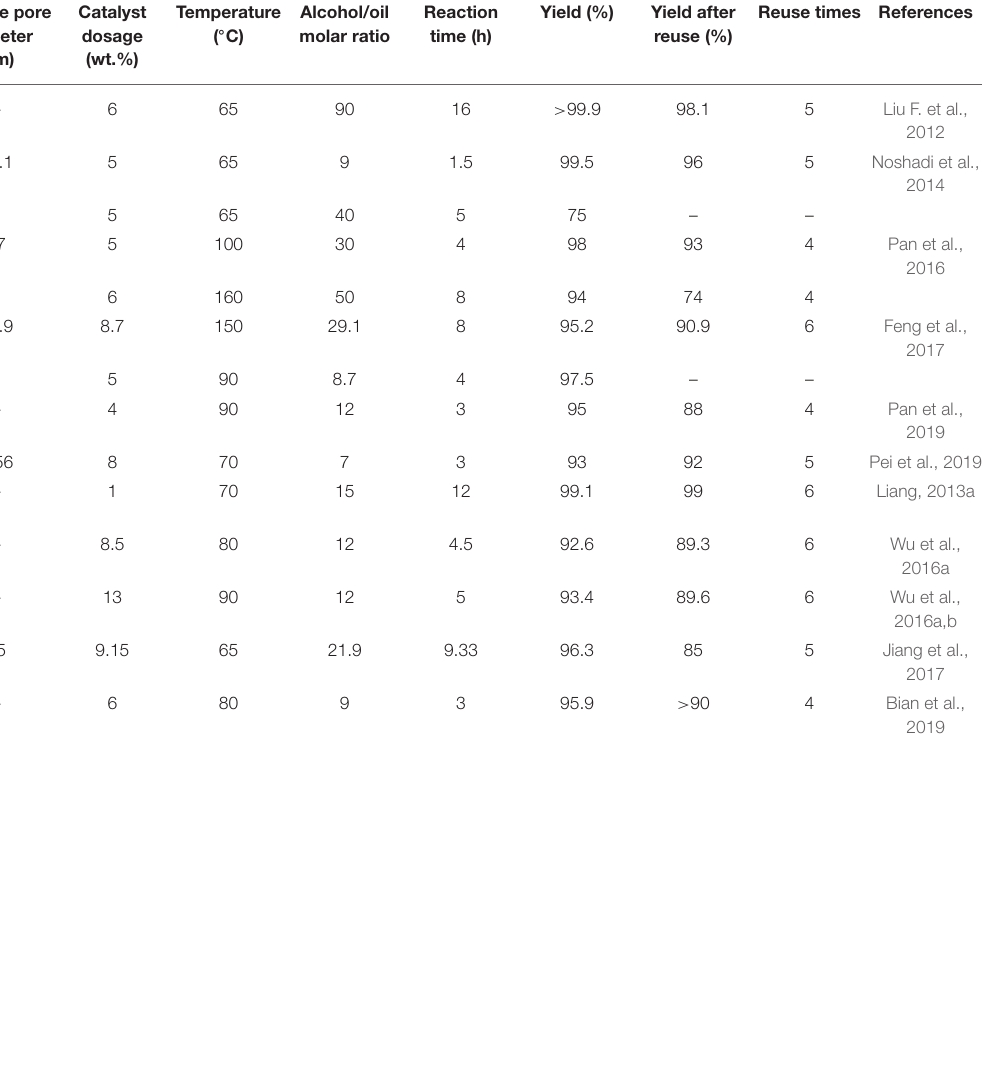
TABLE 2 | Polymeric ionic liquid catalysts for (trans) esterification.